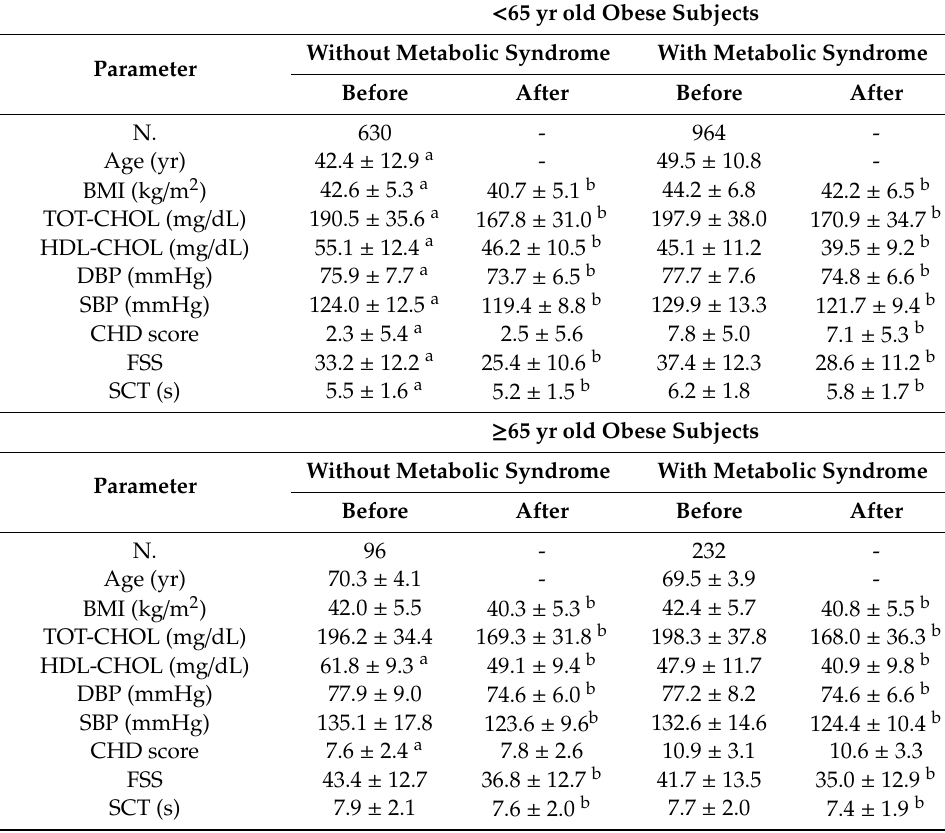
Table 4. Demographic, biochemical, and clinical characteristics of < 65 and ≥ 65 yr old obese subjects (non-older and older subjects, respectively), recruited in the study, subdivided into the two groups with or without metabolic syndrome, who underwent the 3-week